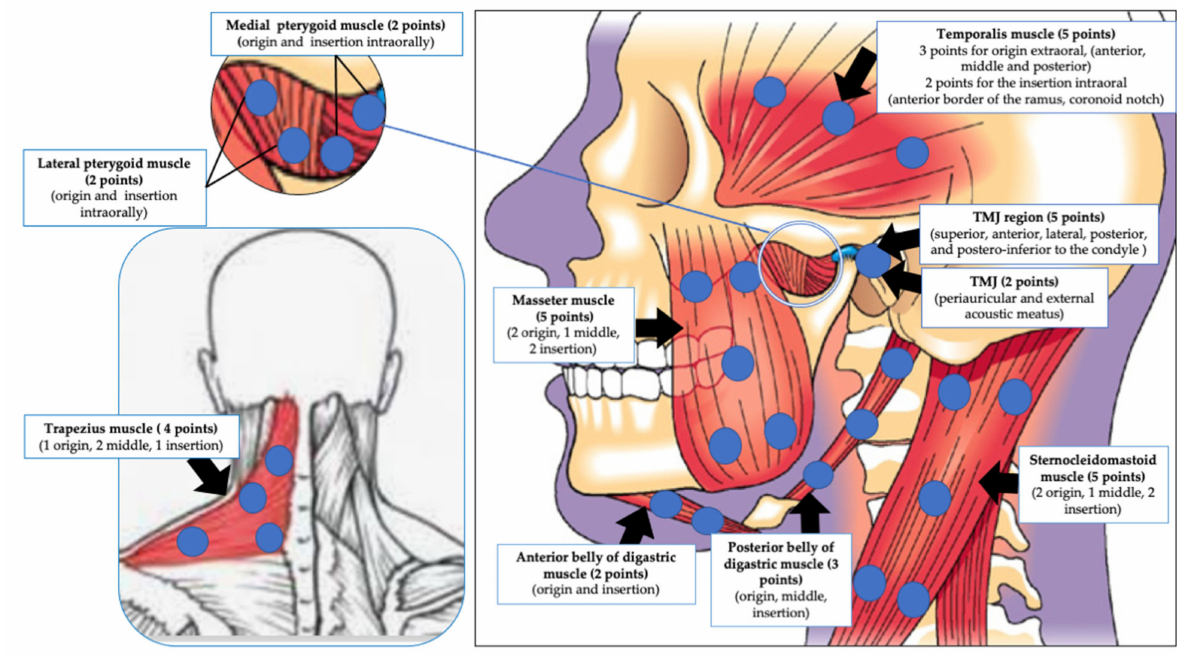
Figure 13. Schematic representation of the proposed suggested number and allocations of the trigger points for PBM irradiation in TMD management. They are based on evidence derived from the literature and expert opinion and are intended only to provide clinical guidance and serve as a starting point for extensive research. The blue circle represents the trigger points’ allocations and their